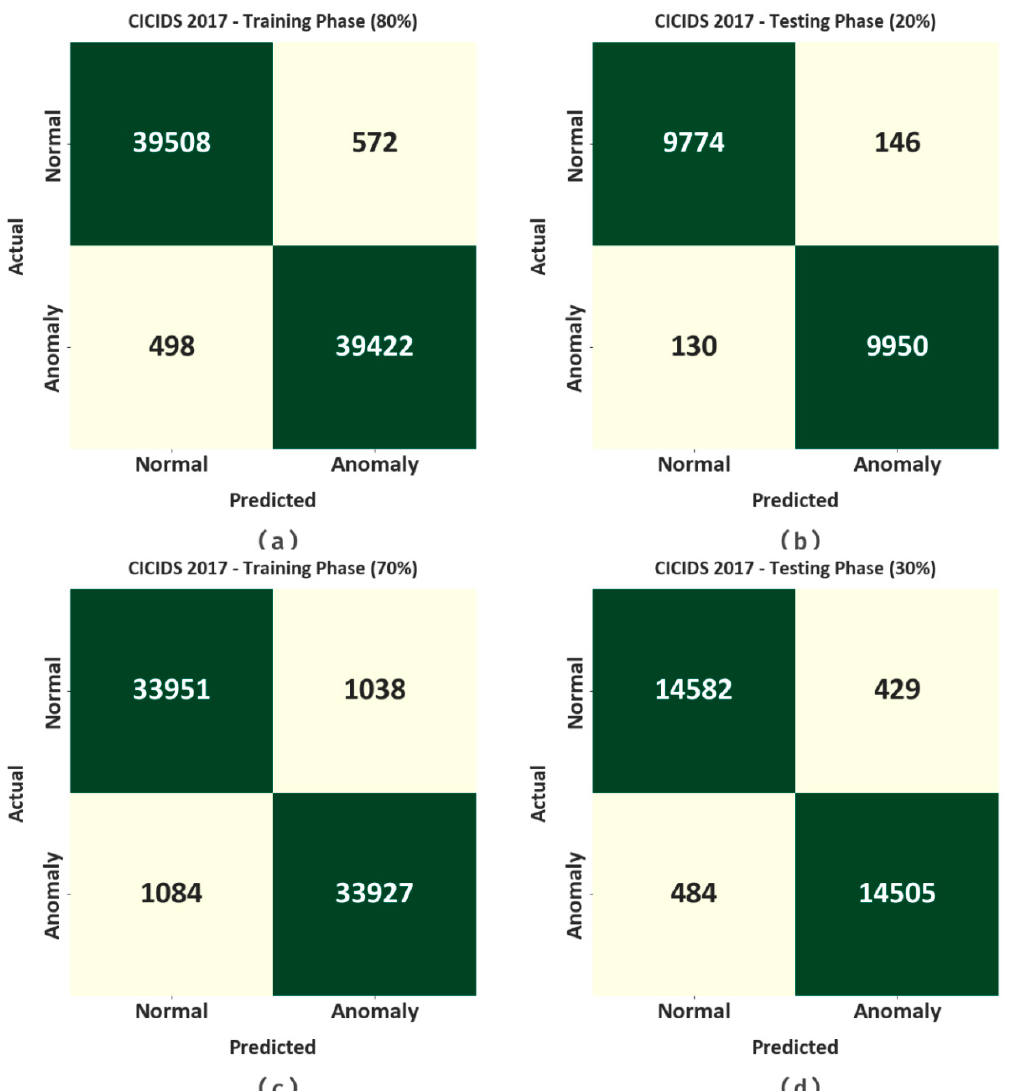
Figure 6. Confusion matrices of XAIID-SCPS system on CICIDS 2017 dataset ( a , b ) TRS/TSS of 80:20 and ( c , d ) TRS/TSS of 70:30.